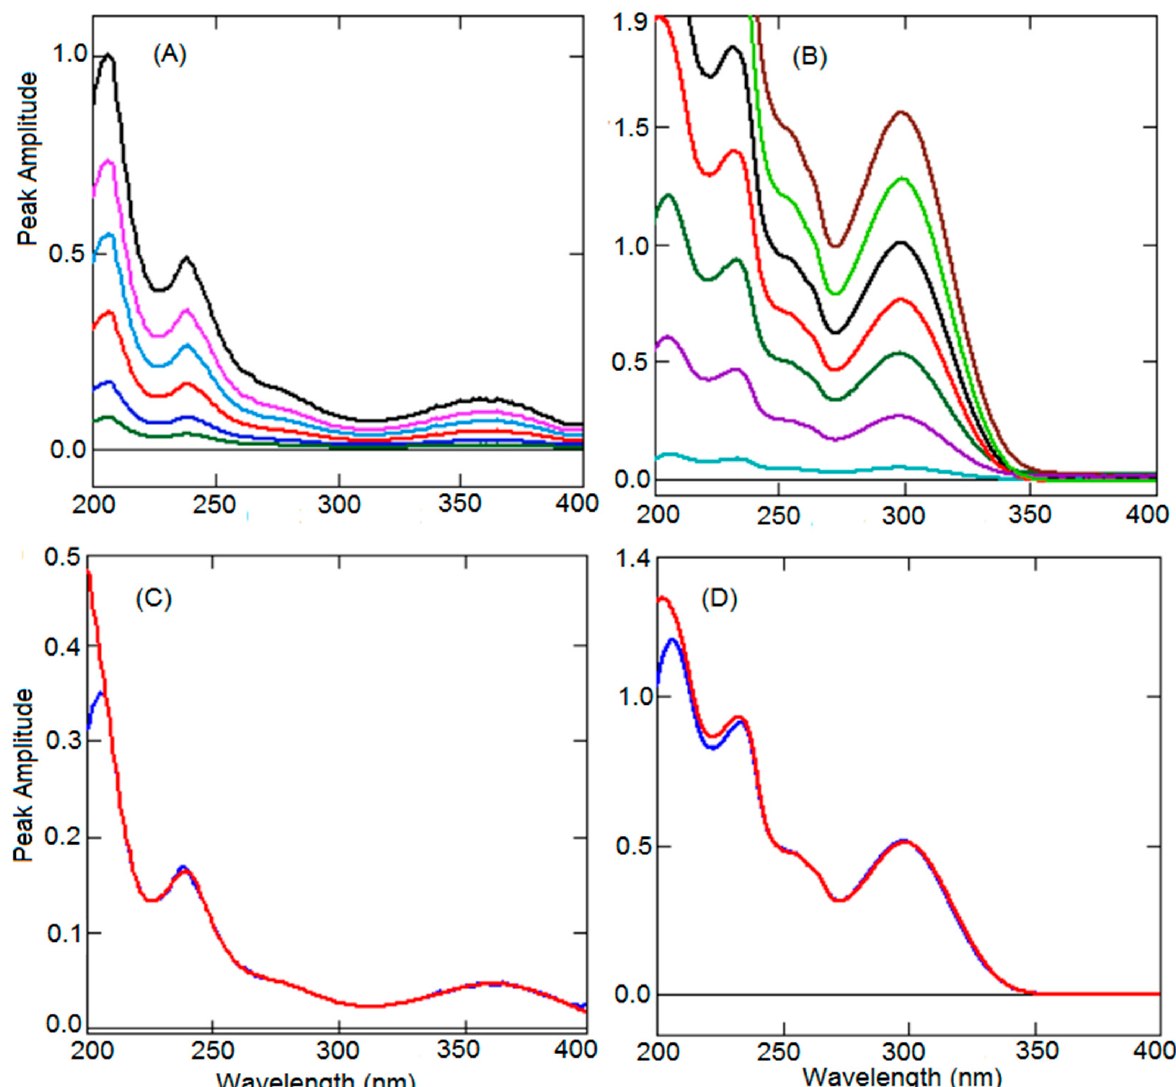
Figure 5. Zero-order spectra of BEN (0.5–10 µg mL − 1 ) ( A ). Zero-order spectra of TEL (1–30 µg mL − 1 ) ( B ). Comparison of zero-order spectra of pure (Red) BEN ( C ) and TEL ( D ) with the mixture (Blue).